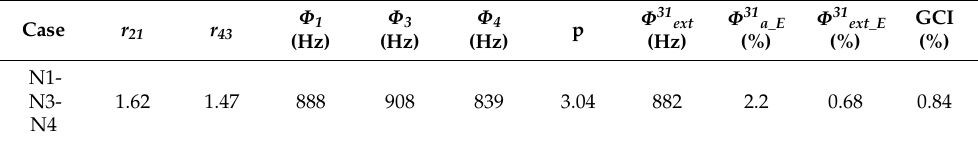
Table 2. Results obtained for the variables of the GCI